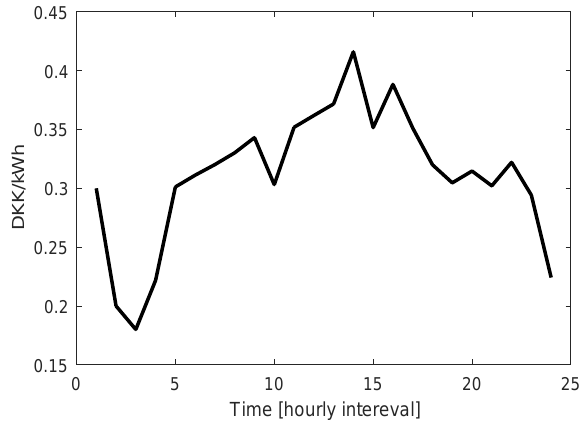
Figure 5. An electricity energy price example from NordPool.